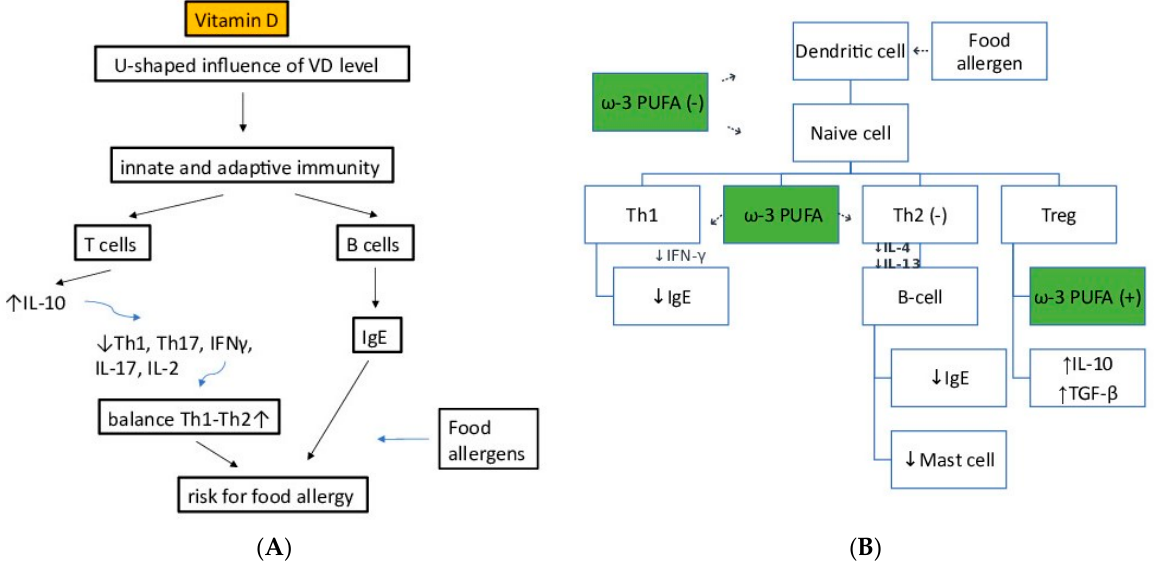
Figure 2. ( A ) The effect of polyunsaturated fatty acids (PUFAs) on food allergy. Vitamin D status affects the inhibitory or stimulatory response of the T cells, and B cells. The allergic reactions are affected through modulation of immune mediators such as IgE and pro- and anti-inflammatory cytokines (interleukins [IL-2, IL-10, IL-17]. ( B ) The effect of omega-3 ( Ω -3) poly unsaturated fatty acids (PUFAs) on food allergy. The colour of the arrows and text indicate evidence obtained from clinical, in vivo or in vitro (green) data. The + or—indicates whether the observed effect is an inhibitory or stimulatory response of a certain cell type. Note that clinical and in vivo arrows indicate the observed end stage effects only; this may not be a reflection of the direct effect of PUFAs on the target cells. Therefore, the components could actually target a cell group earlier in the pathway. ⇢⇢ ↓ IL-4 ↓ IL-23.